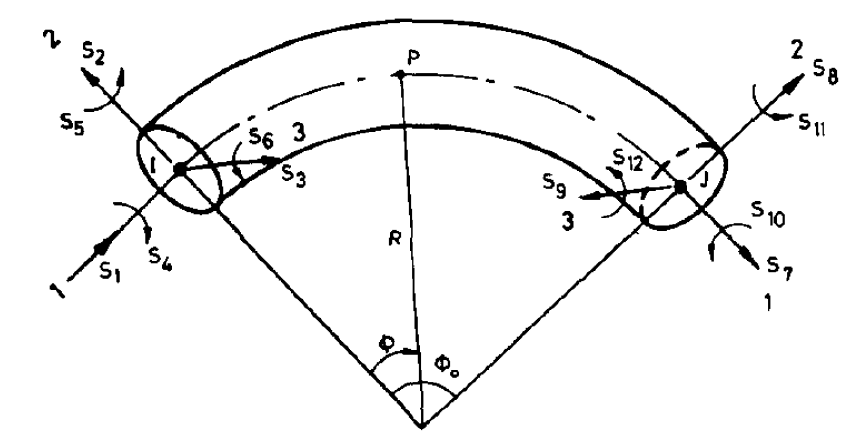
Figure 5. Curved beam element, Palaninathan and Chandrasekharan [12].